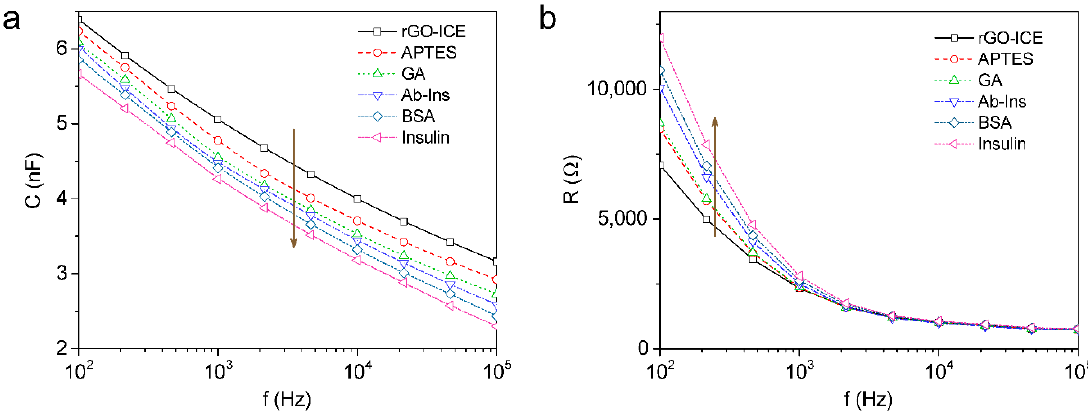
Figure 4. ( a ) Reactive capacitance and ( b ) resistance of the impedance data measured in 10 mM PBS solution (pH 7.0) according to the preparation process for rGO-ICE based insulin sensor.